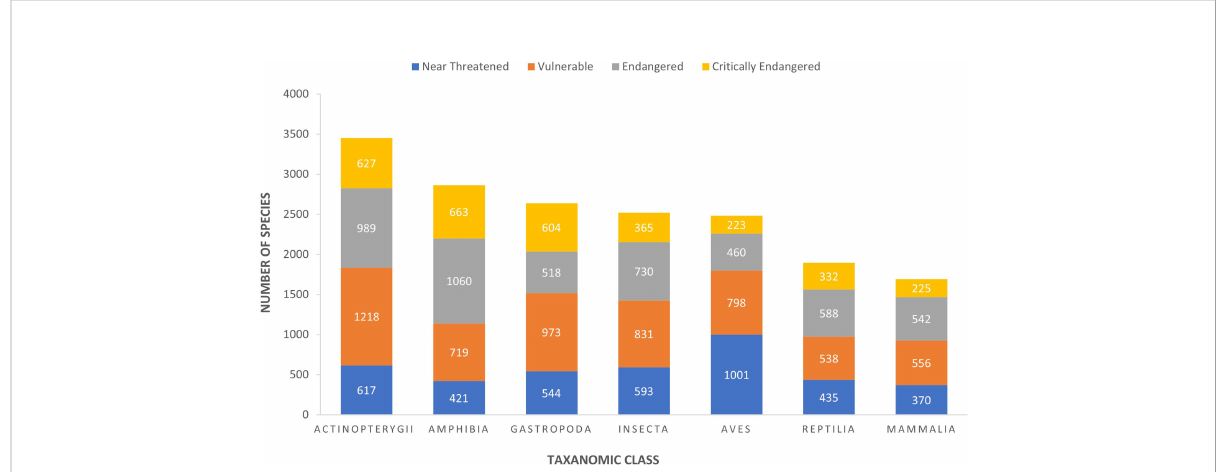
FIGURE 4 Number of species listed in each of the IUCN Red List threatened and near threatened categories ‘ Near Threatened ’ , ‘ Vulnerable ’ , ‘ Endangered ’ and ‘ Critically Endangered ’ , for taxonomic classes with > 1000 species listed.